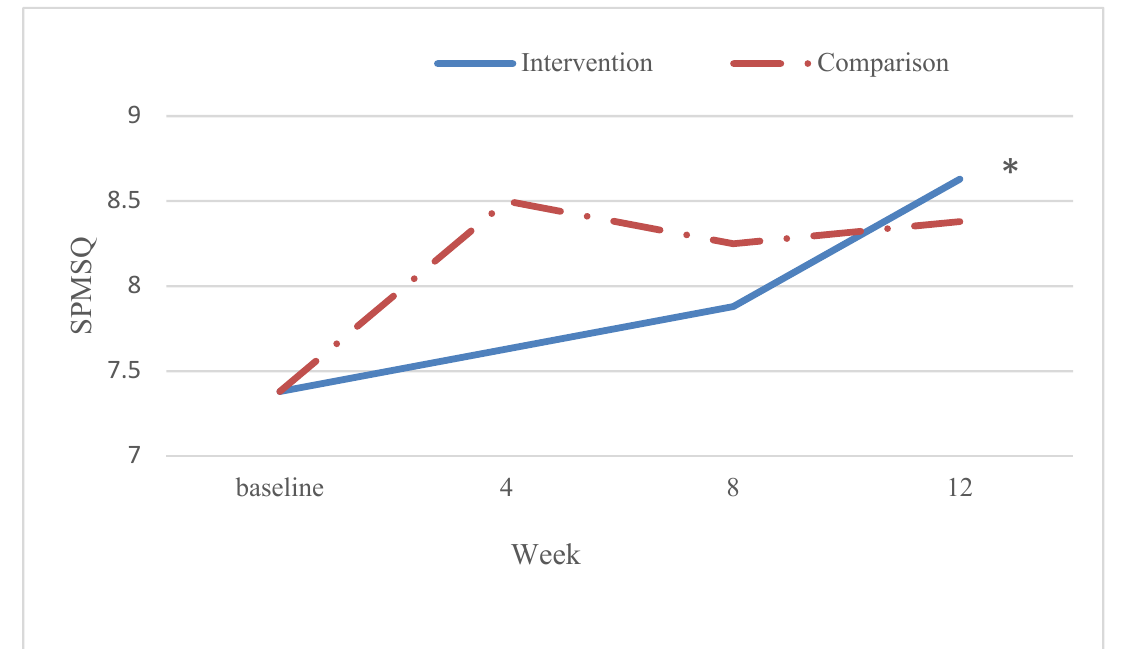
Figure 2. The mean plot for SPMSQ score between the intervention group and comparison group. SPMSQ, Short Portable Mental Status Questionnaire. * p < 0.05. Interaction between group and time.